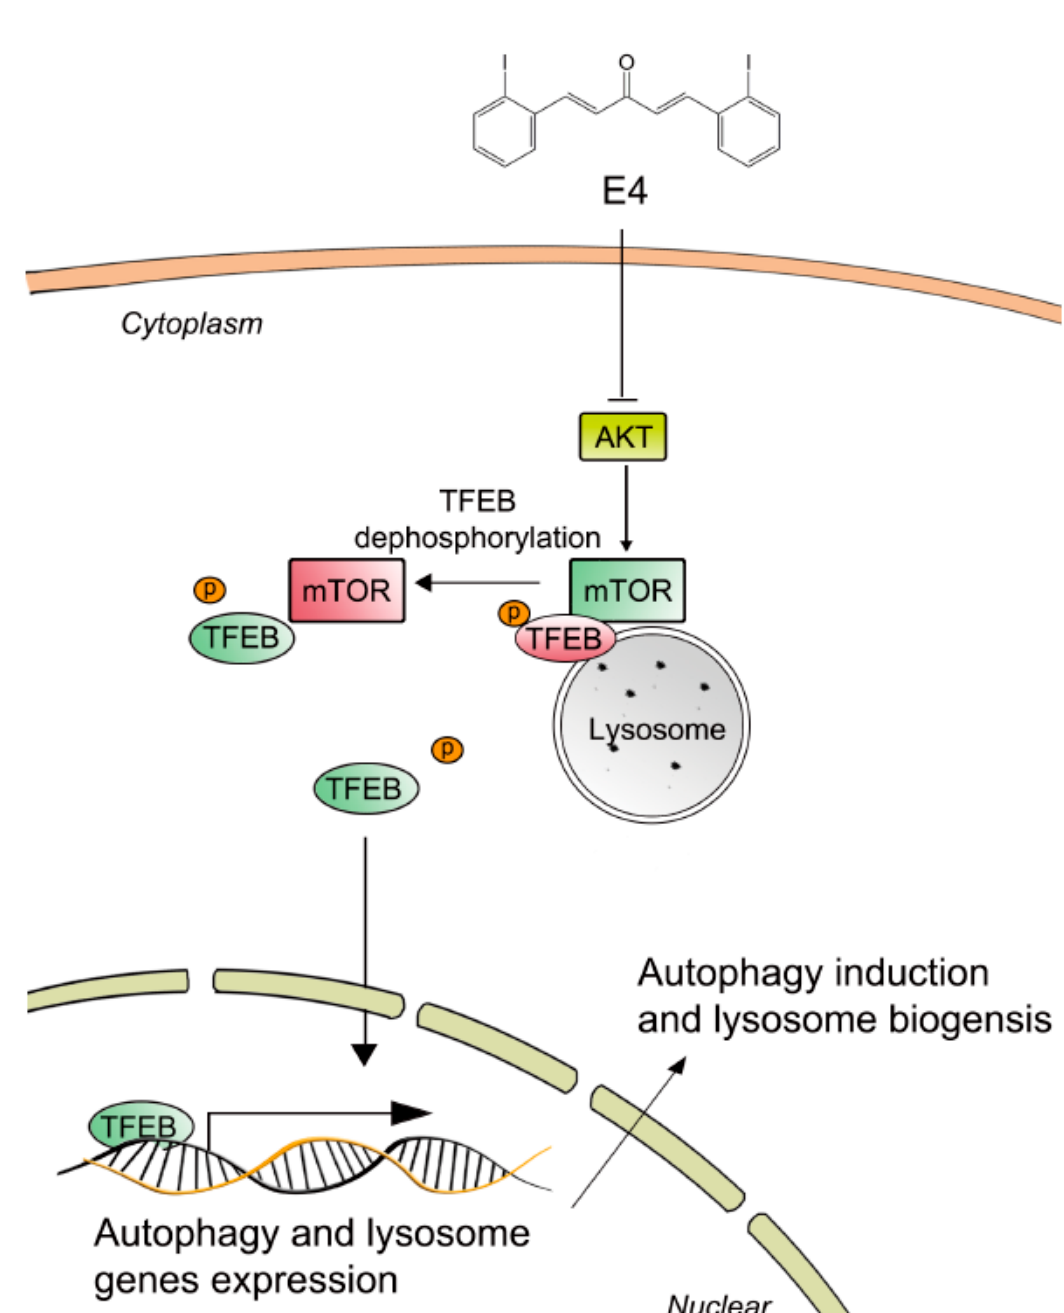
Figure 6. Underlying mechanisms by which compound E4 activate TFEB and autophagy-lysosome process. Compound E4 inhibited AKT as well as MTORC1 pathway and further promoted the nuclear accumulation of TFEB. Cytoplasmic TFEB is highly phosphorylated and located in the surface of lysosome which bind with MTOR. Compound E4 inhibited the MTOC1 activity and promoted TFEB dephosphorylation. Dephosphorylated TFEB translocated into nucleus and bind to autophagy and lysosome related genes site. Eventually, compound E4 promoted TFEB from cytoplasm to nucleus and induced autophagy and lysosome biogenesis.